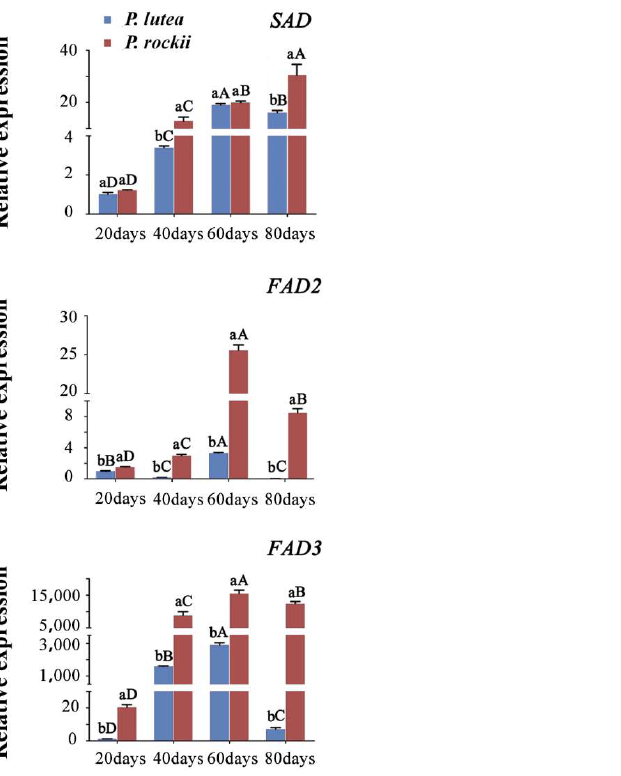
Figure 6. Validation of expression pattern for desaturases by qPCR. For gene abbreviations see Table S4. Different small letters indicate significant differences between the species at the same time point at p < 0.05 level, as determined by the least significant differences test. Different capital letters indicate significant differences among different time points for the same